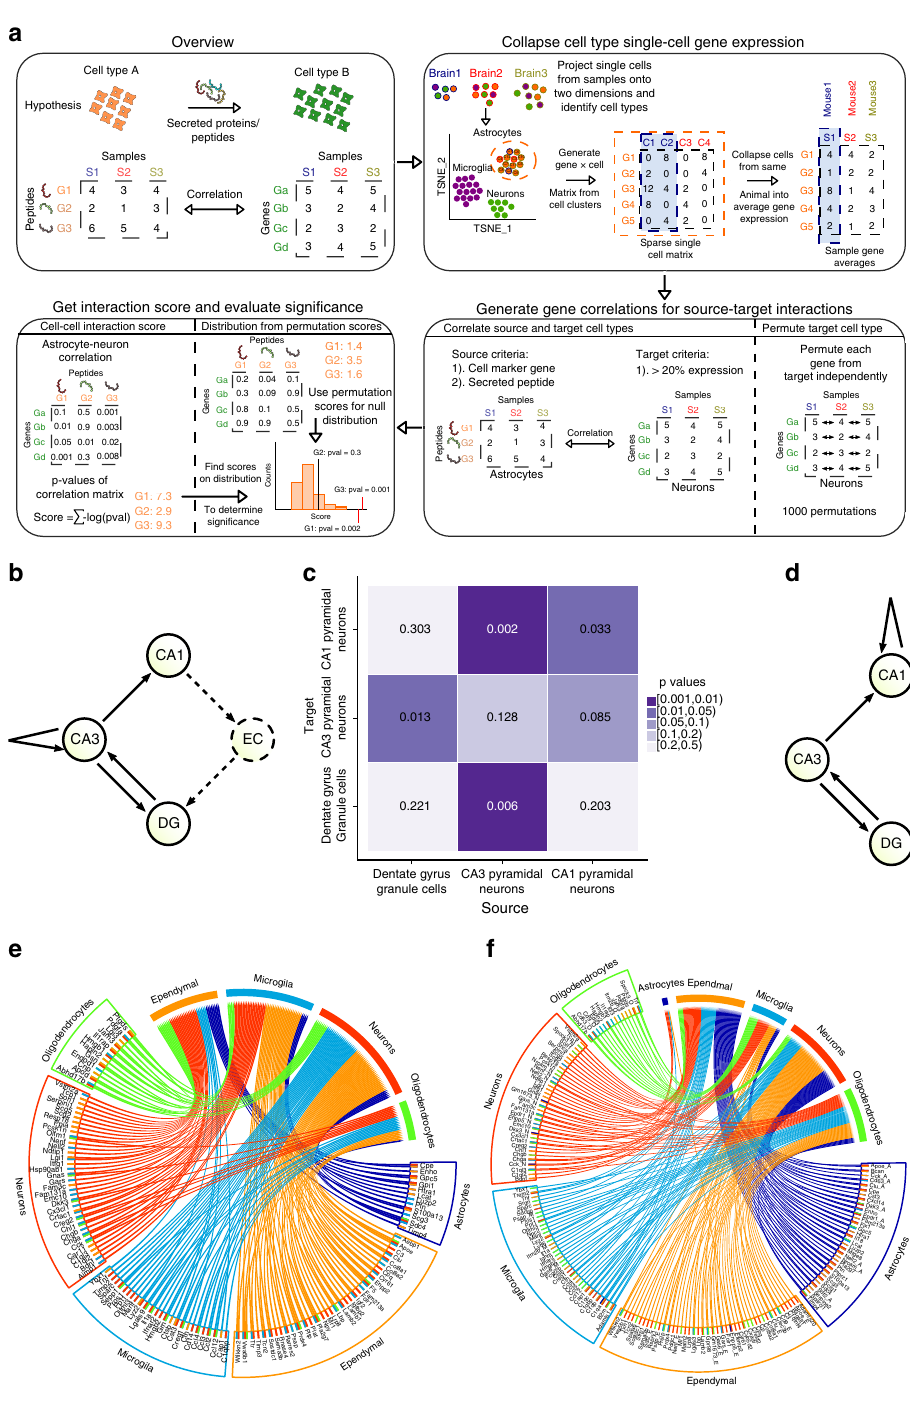
Identi fi cation of genes and pathways vulnerable to mTBI . To determine speci fi c genes and pathways that may confer mTBI pathogenesis in each hippocampal cell type and to further re fi ne the vulnerable cell types, we identi fi ed differentially expressed genes (DEGs) between Sham and mTBI within each cell cluster (Table 1; all DEGs in Supplementary Data 3) at false discovery rate (FDR) <0.05. Astrocytes, oligodendrocytes, and neurons had the largest numbers of DEGs between mTBI and Sham samples (Table 1). Annotation of the DEGs with curated biological pathways from KEGG 25 , Reactome 26 , BIOCARTA, and Gene Ontology 27 databases identi fi ed key pathways that could explain